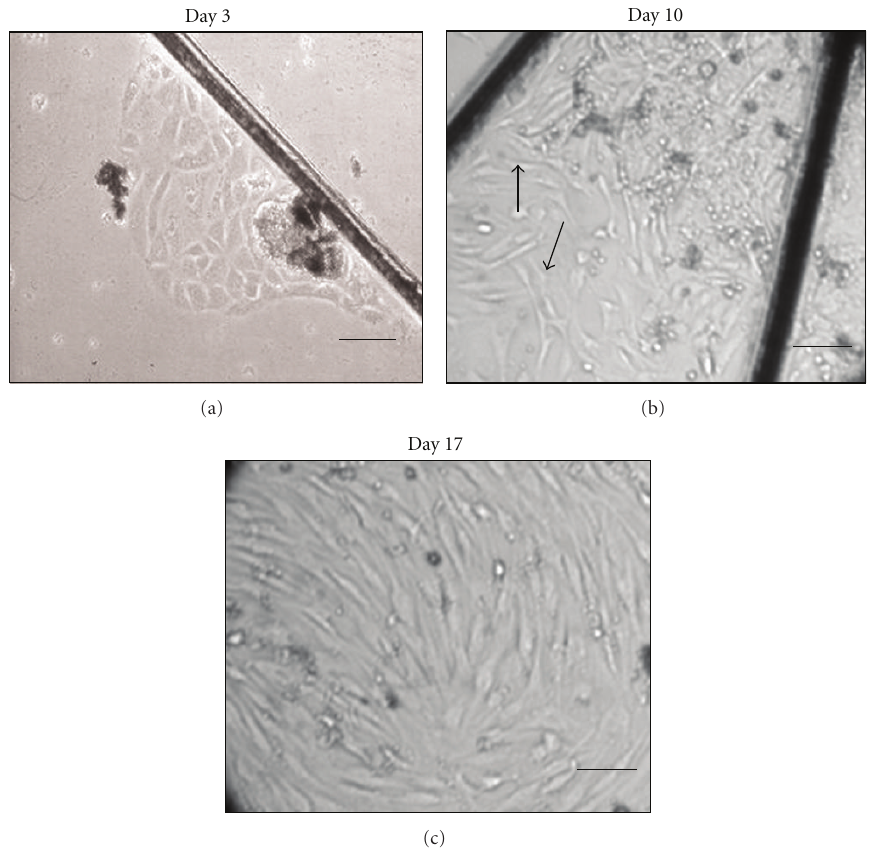
Figure 1: Phase contrast light microscopy of tissue at 3, 10, and 17 days after explanting. (a) Cuboidal-shaped cells are clearly seen propagating from explanted tissue at day 3. (b) By day 10 cells at the periphery have a more elongated morphology (arrows). (c) At day 17, confluent areas of cells form fingerprint patterns, characteristic of fibroblast culture. Diagonal line shows scratch in Petri dish used to mince tissue and anchor tissue to culture surface. Scale bar = 25 μ